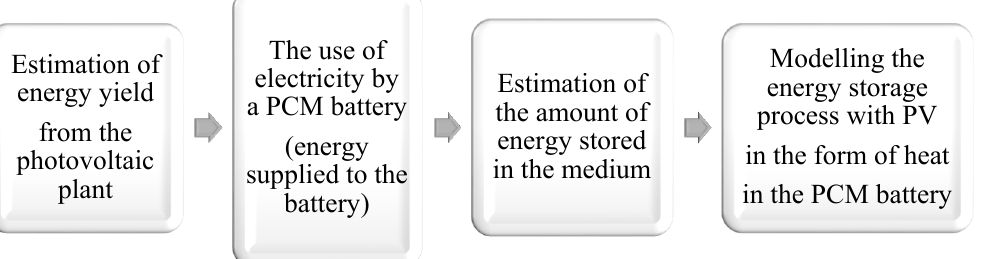
Figure 5. Block diagram of the stages of modelling the energy storage system in the PCM battery.